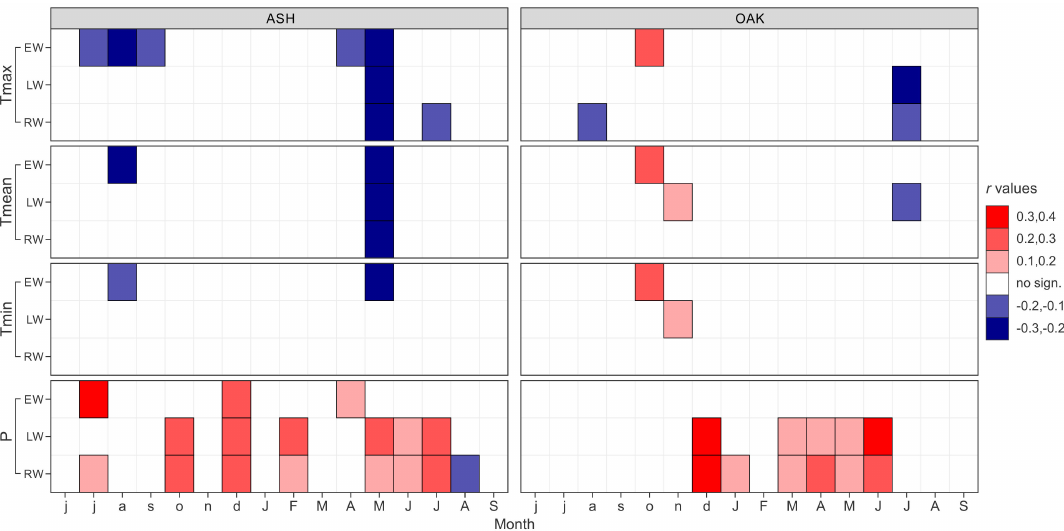
Figure 4. Climate–growth relationship for ash and oak, using monthly climatic data: maximum, minimum and mean temperature (Tmax, Tmin, and Tmean) and precipitation amount (PP), and tree-ring indices earlywood (EW), latewood (LW), and tree ring-widths (RW), over the period